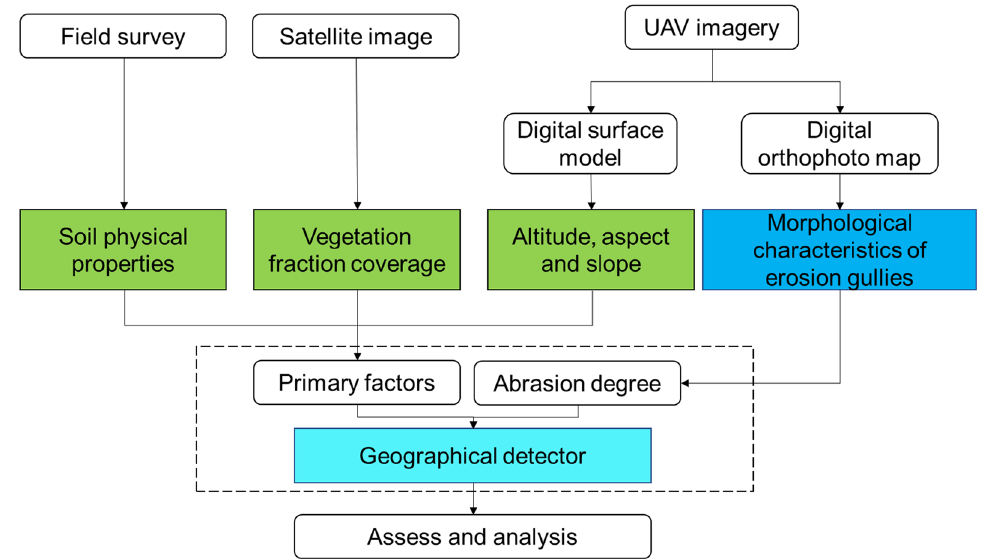
Fig. 4 Methodology flow chart in this